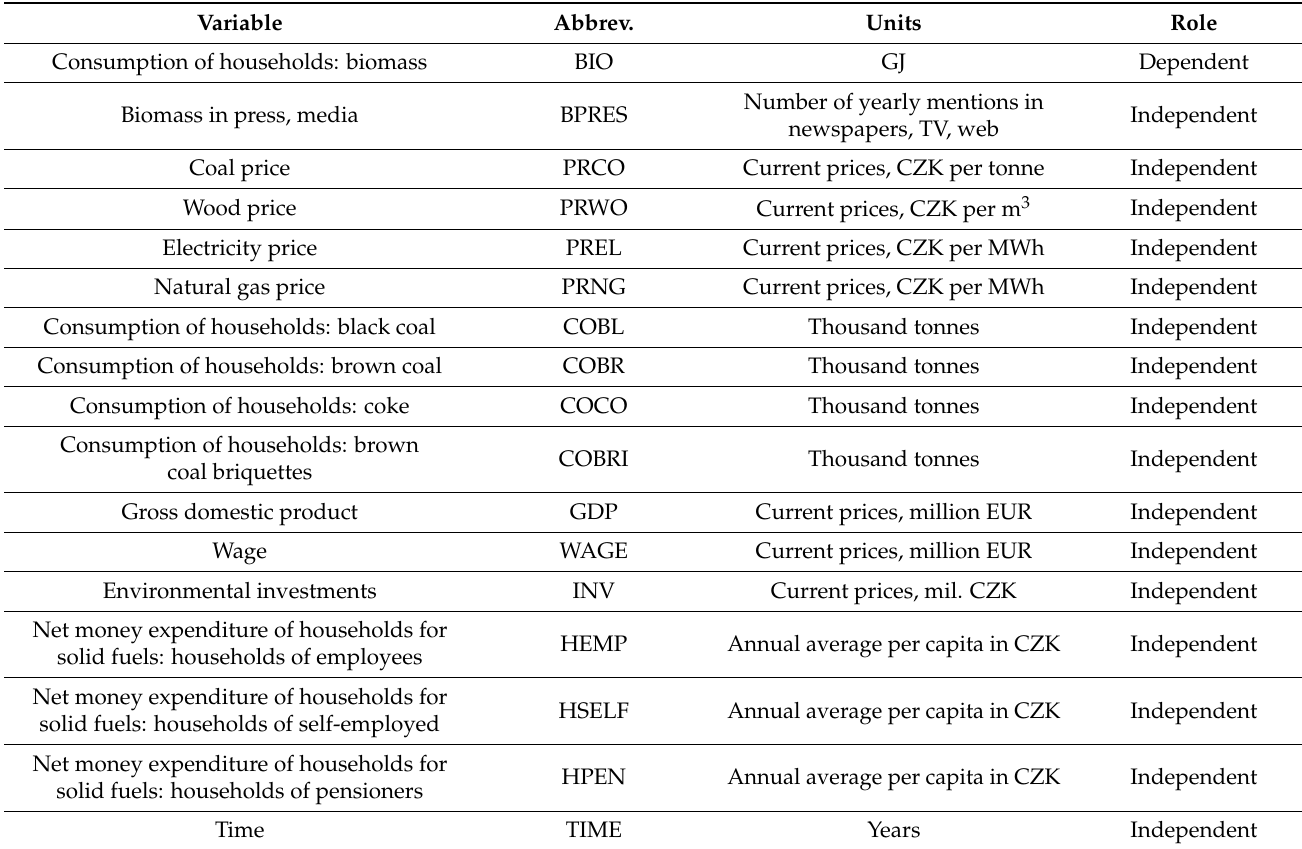
Table 1. List of